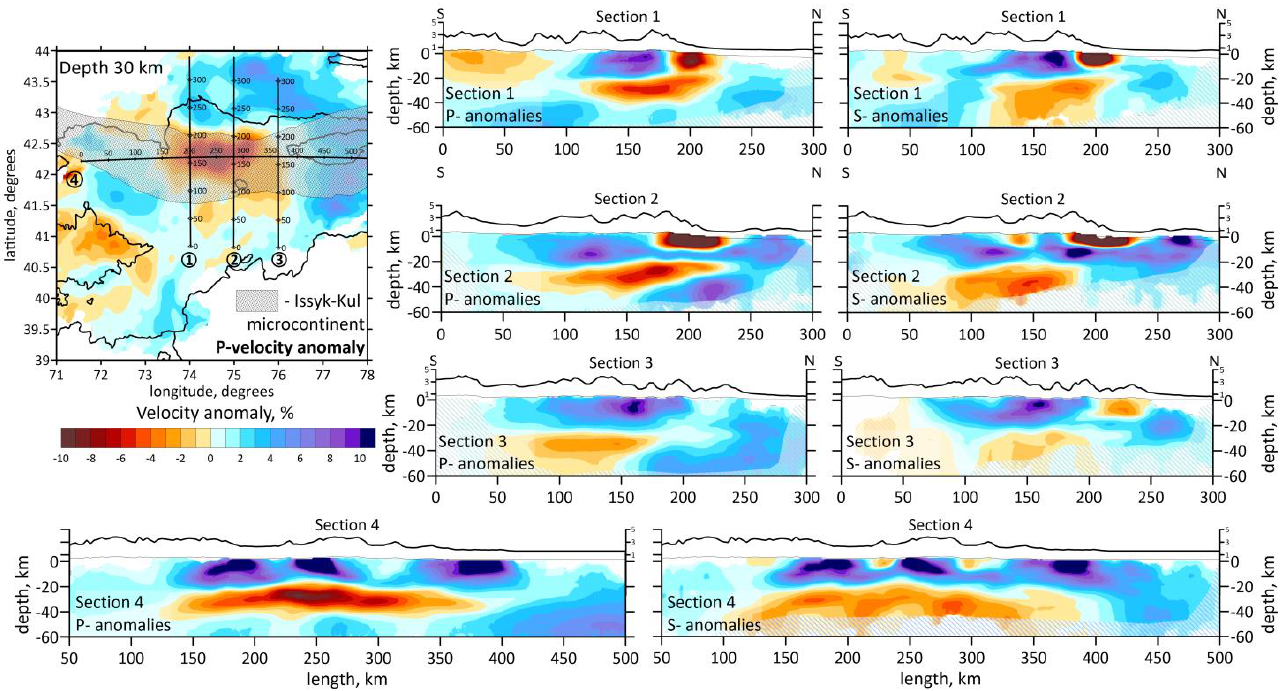
Figure 5. P- and S-velocity anomalies in the vertical sections.